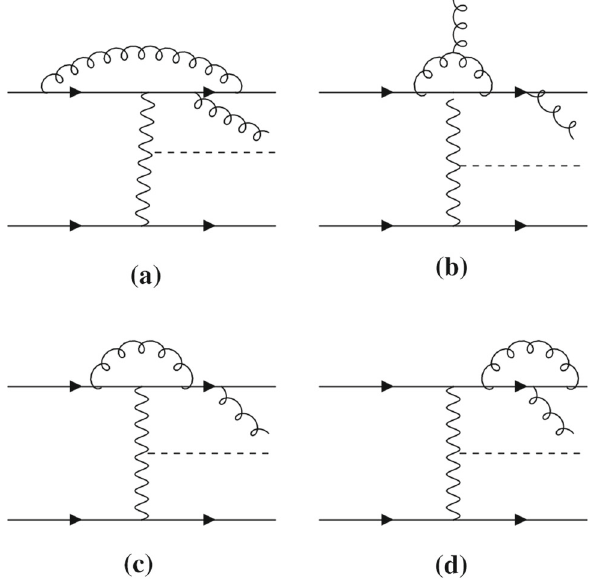
Fig. 2 Representative one-loop Feynman diagram topologies for h +